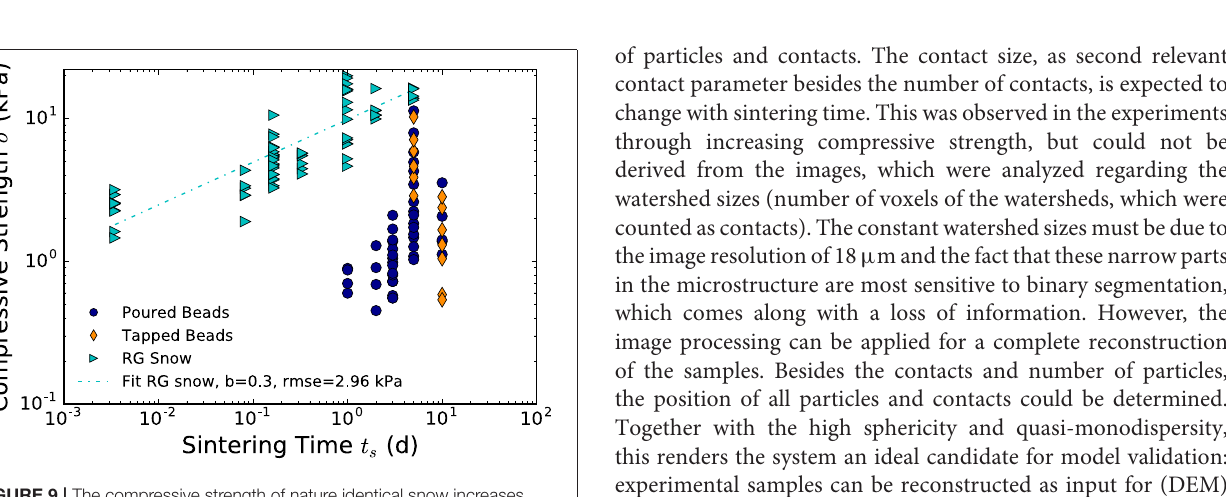
range of 20–300 µ m. No measure for the sphericity was